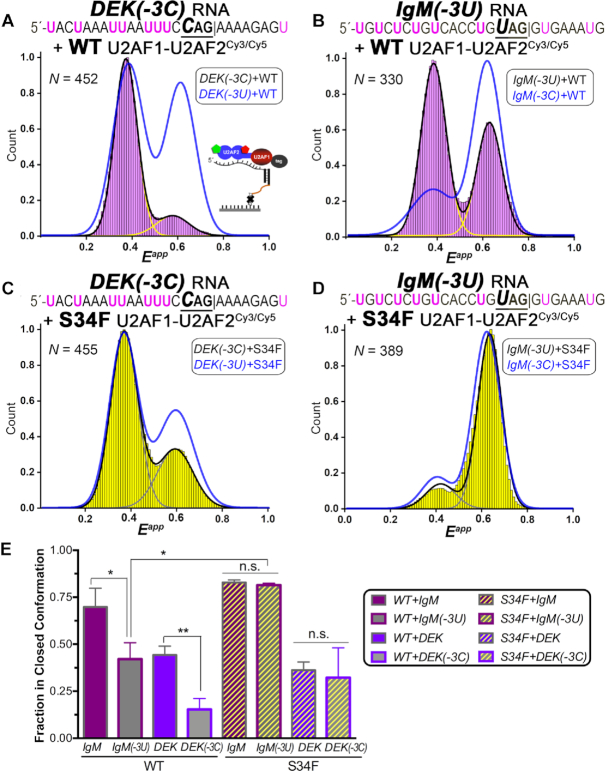
Influence of a -3C versus -3U nucleotide preceding the splice site junction on the of apparent FRET efficiencies (Eapp) of the wild-type (WT) and S34F mutant U2AF1–U2AF2Cy3/Cy5 heterodimers, including (A) WT U2AF1–U2AF2Cy3/Cy5 bound to DEK(-3C) RNA, (B) WT U2AF1–U2AF2Cy3/Cy5 bound to IgM(-3U) RNA, (C) S34F U2AF1–U2AF2Cy3/Cy5 bound to DEK(-3C) RNA, (D) S34F U2AF1–U2AF2Cy3/Cy5 bound to IgM(-3U) RNA. The ribonucleoproteins are tethered via the bound RNAs as inset in panel A and shown in Figure 3D. Black lines indicate the summed Gaussian fits of the histograms, and yellow or gray lines indicate the individual fits. The summed fits of the FRET histograms for the natural splice sites (DEK(-3U) or IgM(-3C)) bound to the corresponding WT or S34F mutant heterodimers are overlaid in blue for comparison. (E) Bar graph showing the fraction of U2AF1–U2AF2Cy3/Cy5 in the closed conformation determined from the area under the Gaussian centered at 0.6 FRET normalized to the sum of Gaussians centered at 0.4 and 0.6 FRET, plotted as in Figure 6G.